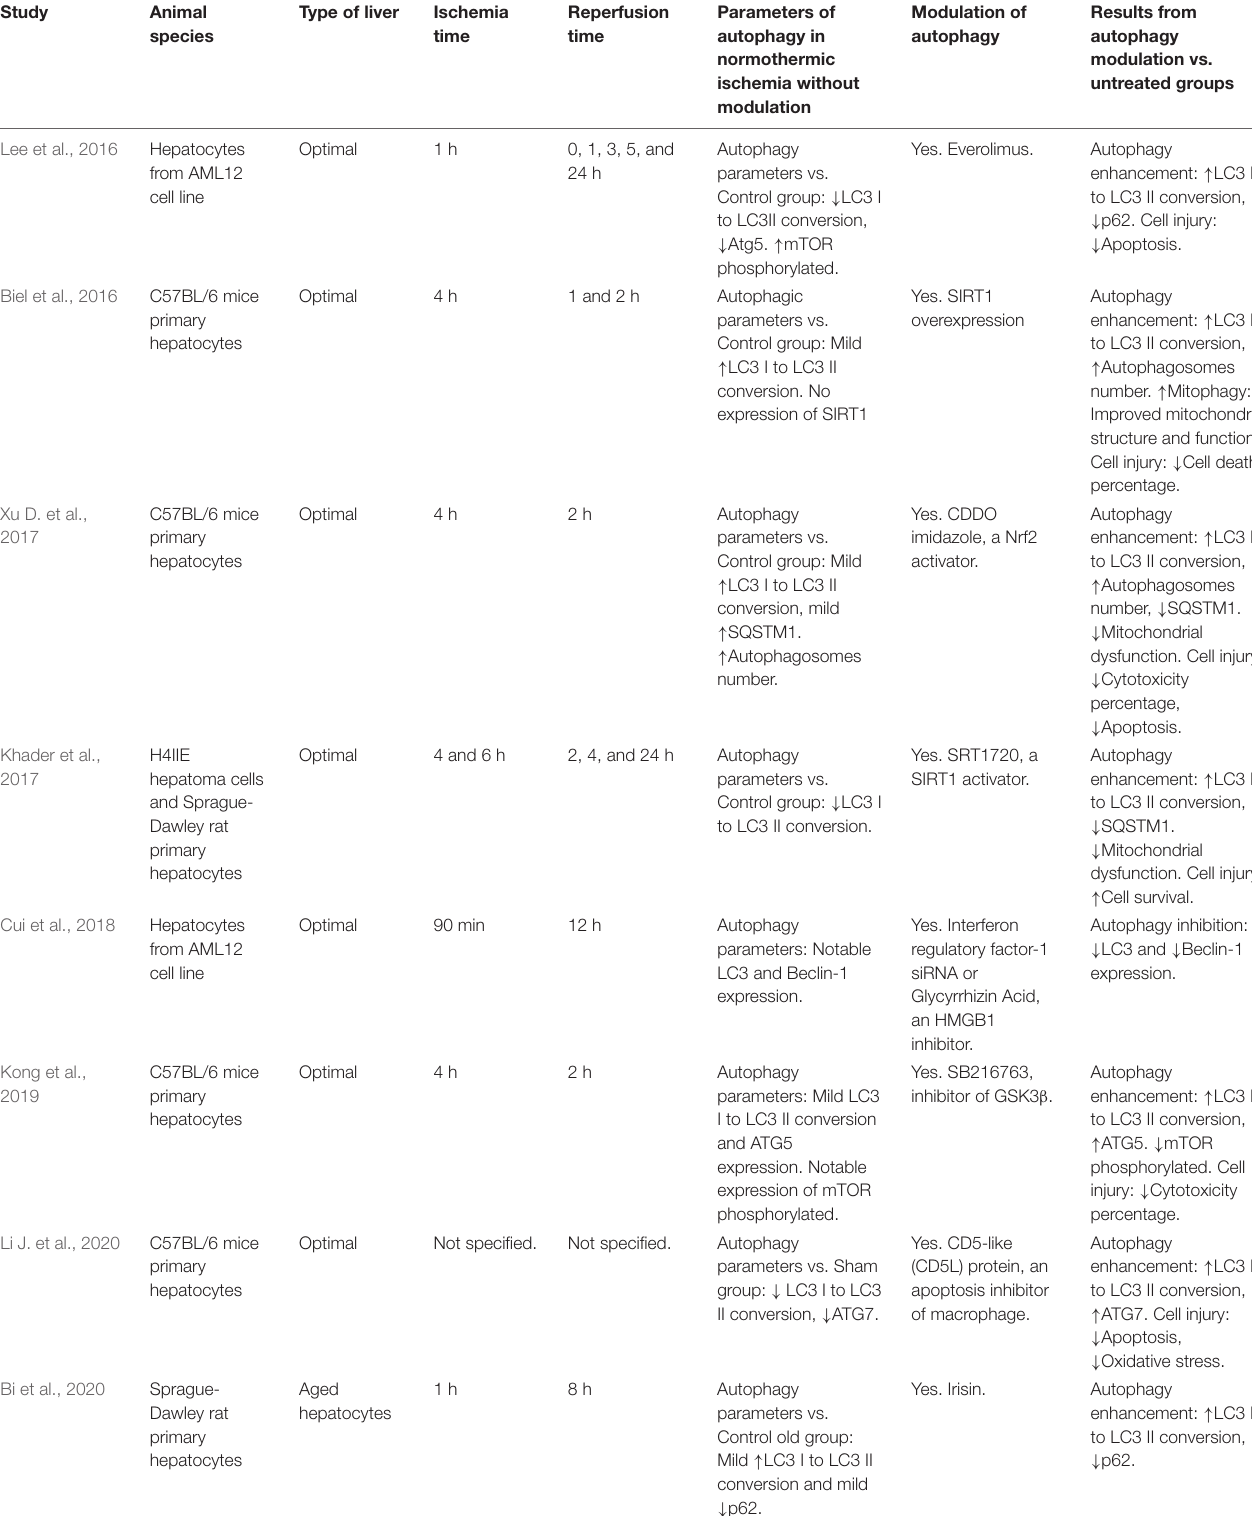
TABLE 1 | Outcomes about the role of autophagy in normothermic hepatic I/R injury, in the last 5